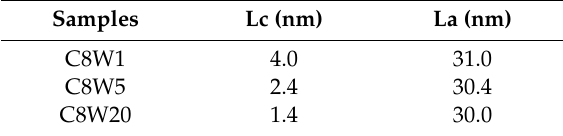
ff erent samples.